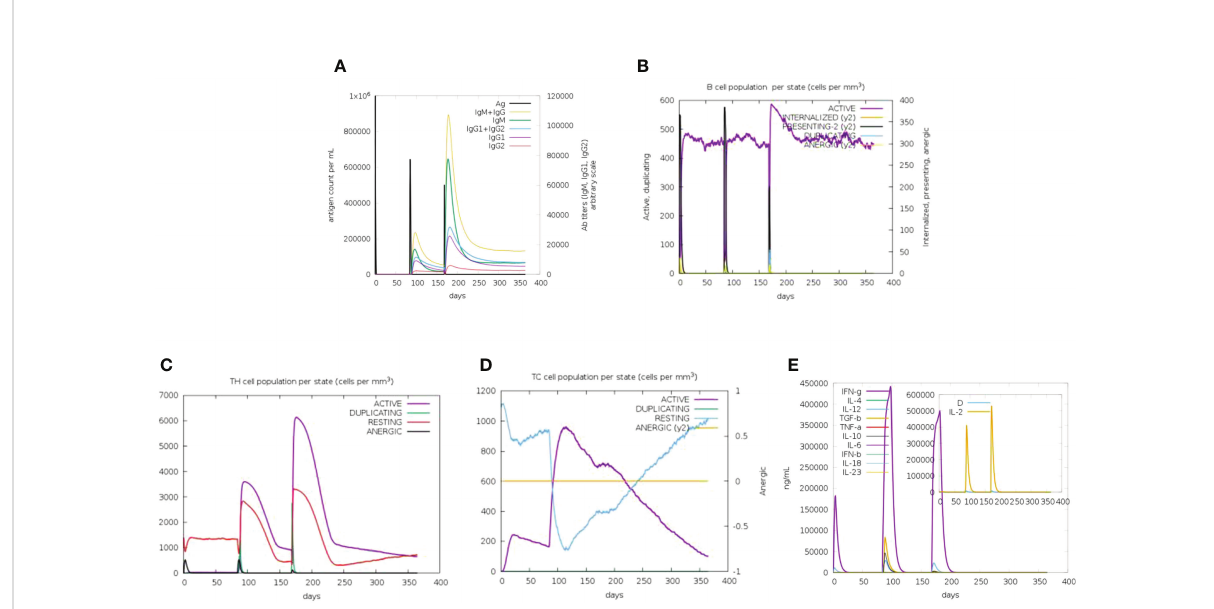
FIGURE 3 In-silico immune simulation of the CVB vaccine by the C-ImmSim tool. (A) Antibody production in response to antigen injections (vertical black lines). (B) Level of B-cell population. (C) Level of helper T-cell population. (D) Level of cytotoxic T-cell population. (E) Level of cytokine expression.